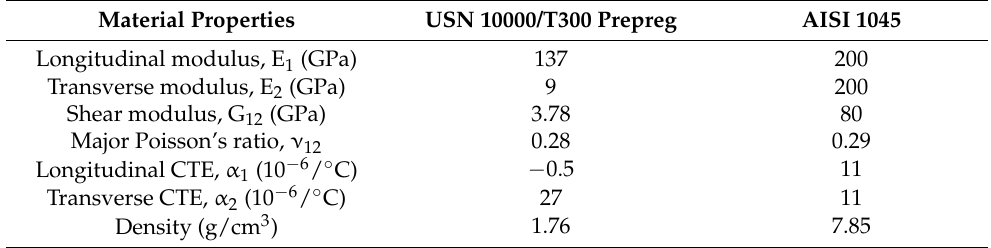
Table 1. Material properties of the unidirectional CFRP prepreg and the steel square